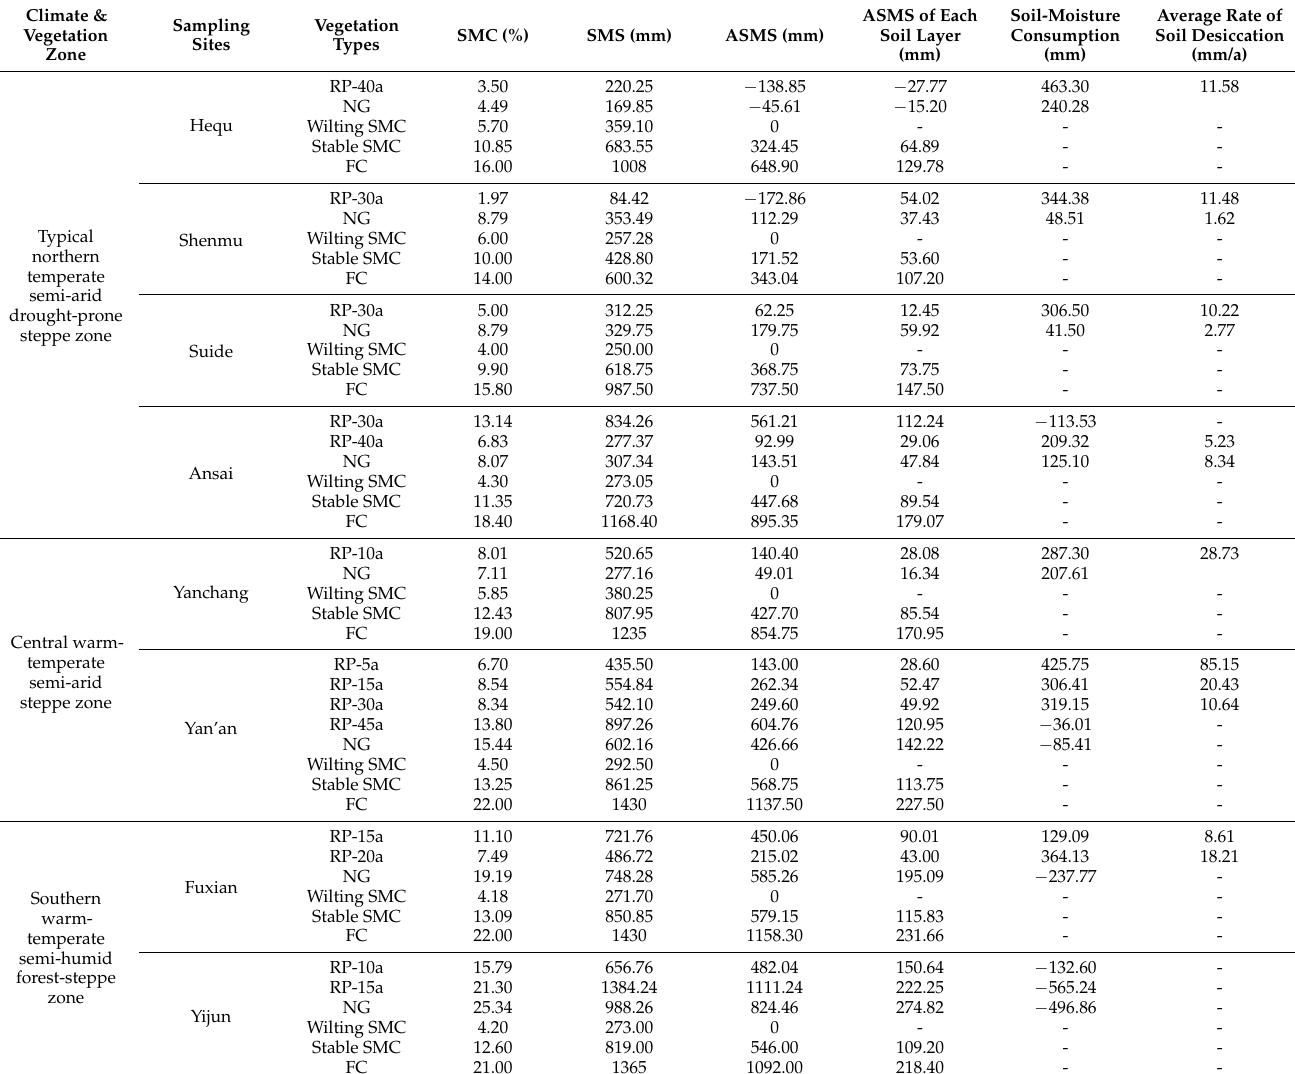
Table 3. Comparison of soil-moisture content under R. pseudoacacia sites on the Loess Plateau of